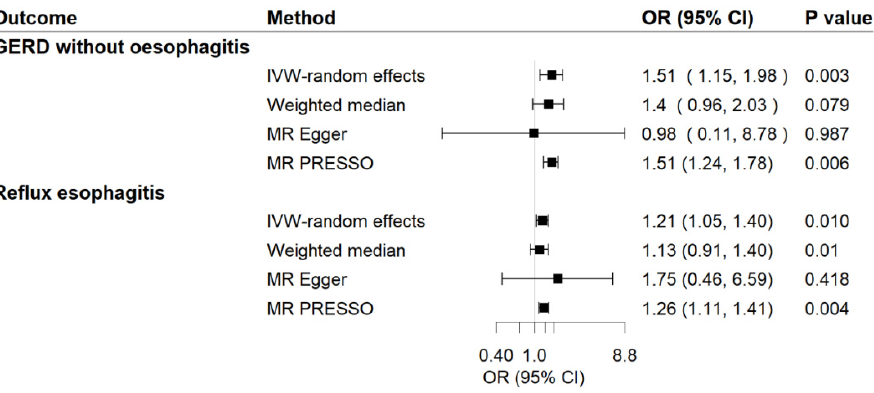
Figure 3. Associations of MDD with risk of GERD phenotypes in MR analyses. The ORs of GERD phenotypes were scaled to a 1-unit increase in log OR of MDD. IVW, inverse variance weighted; OR, odds ratio; CI, confidence interval; MR, Mendelian randomization.